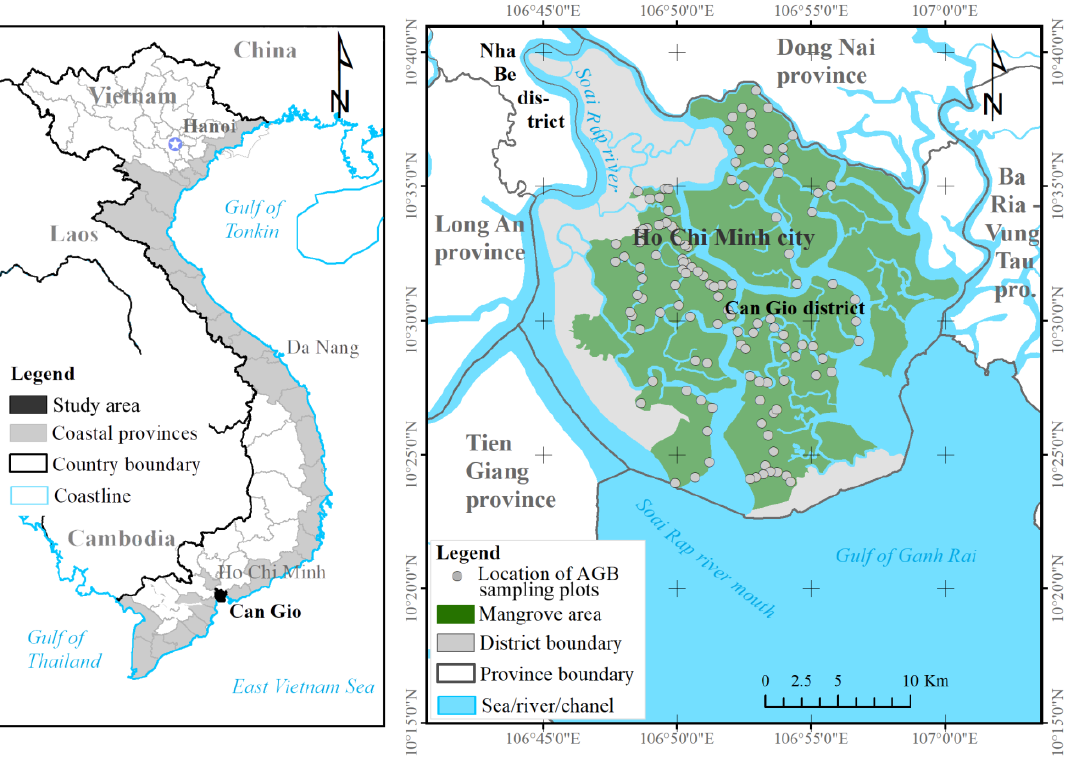
Figure 1. Location map of study areas.